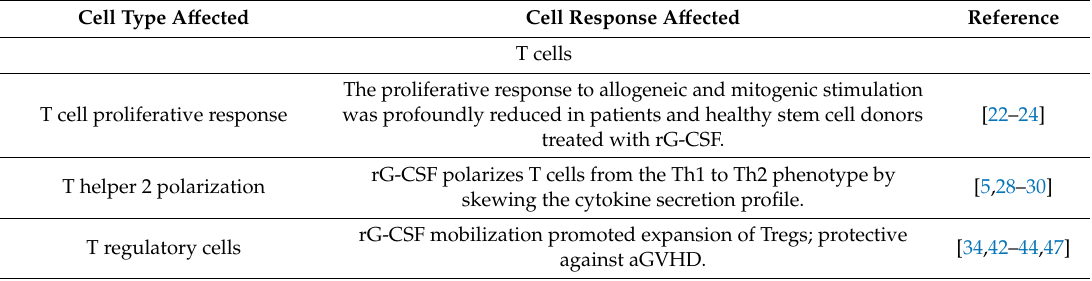
Table 1. The immunomodulatory e ff ects of recombinant granulocyte colony-stimulating factor